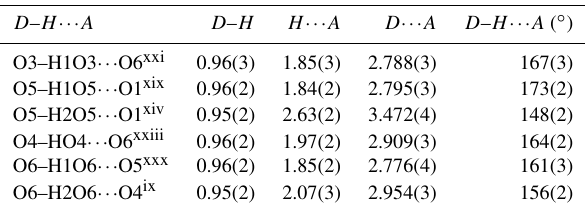
Table 7. Hydrogen-bond geometry (in ångströms and degrees) in the structure of liroconite.